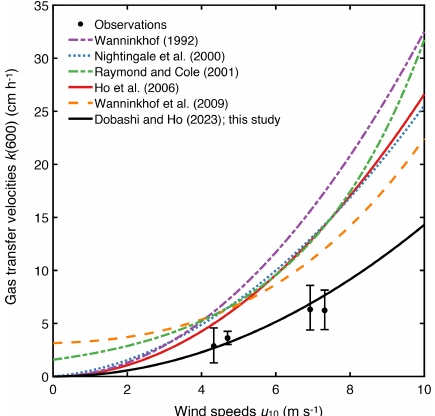
Figure 3. Measured and modeled k (600) (cmh − 1 ) with wind speed at 10m height (ms − 1 ).